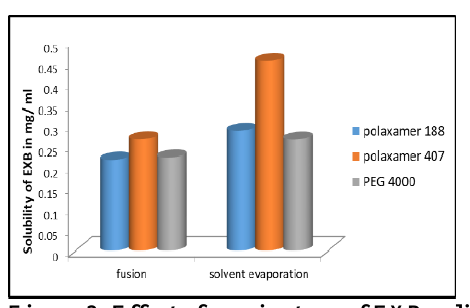
Figure 3. Effect of carrier type of EXB solid dispersion at a ratio (1:3) on the solubility of EXB in distilled water at 25°C .